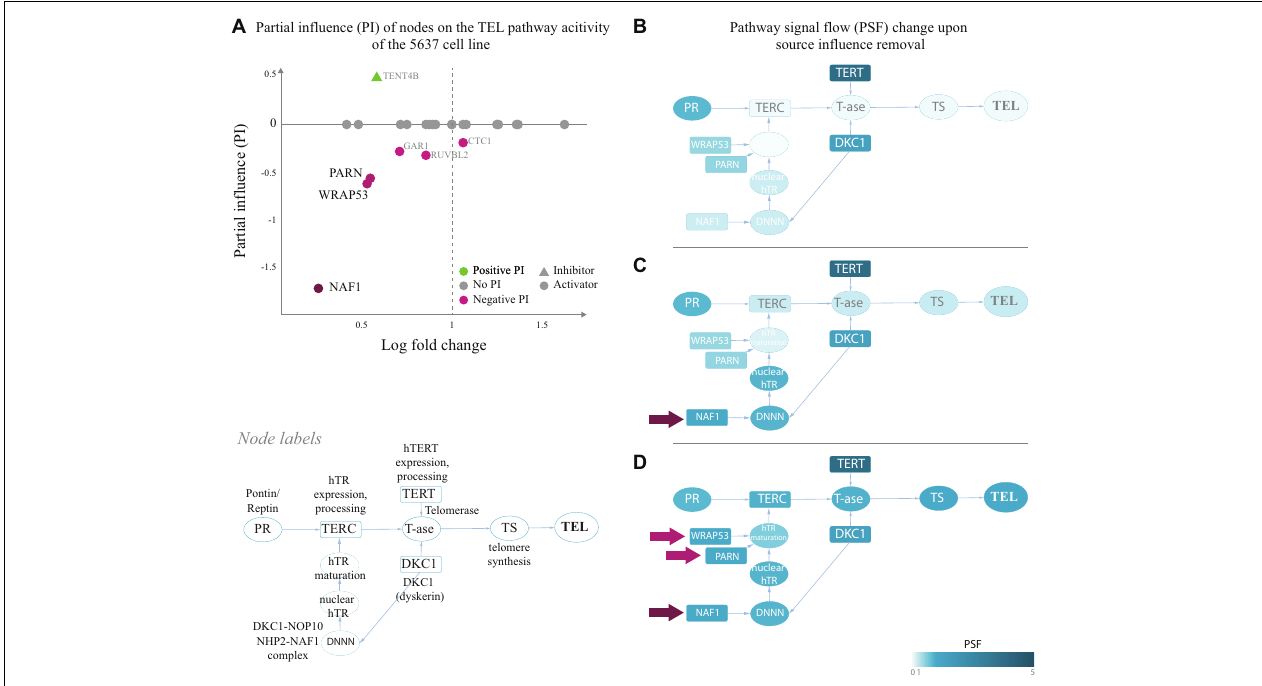
FIGURE 3 | Partial influence of nodes on the TEL pathway activity of the 5,637 cell line. (A) Partial influence (PI) of each node is computed as the difference of the TEL node PSF value when the node is set to a fold change (FC) value of 1. In the first replicate of the 5,637 cell line, the genes involved in maturation of the telomerase RNA component hTR ( NAF1 , WRAP53, and PARN ), have the largest negative influence on the TEL pathway activity. Low expression of these genes leads to inactivation of the TERC branch, which is the bottleneck in telomerase complex formation (B) . The pathway becomes activated when the influence of NAF1 (C) or NAF1, WRAP53, and PARN (D) is removed by setting their FC to 1 (see section “Materials and Methods”).